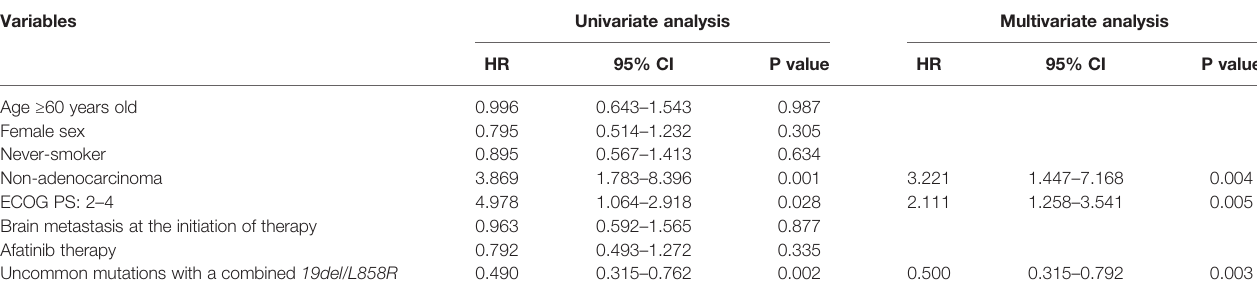
TABLE 4 | Cox regression analysis for prognostic factors in the 102 advanced NSCLC patients harboring uncommon EGFR mutations who received EGFR -TKIs as fi rst-line therapy. Variables Univariate